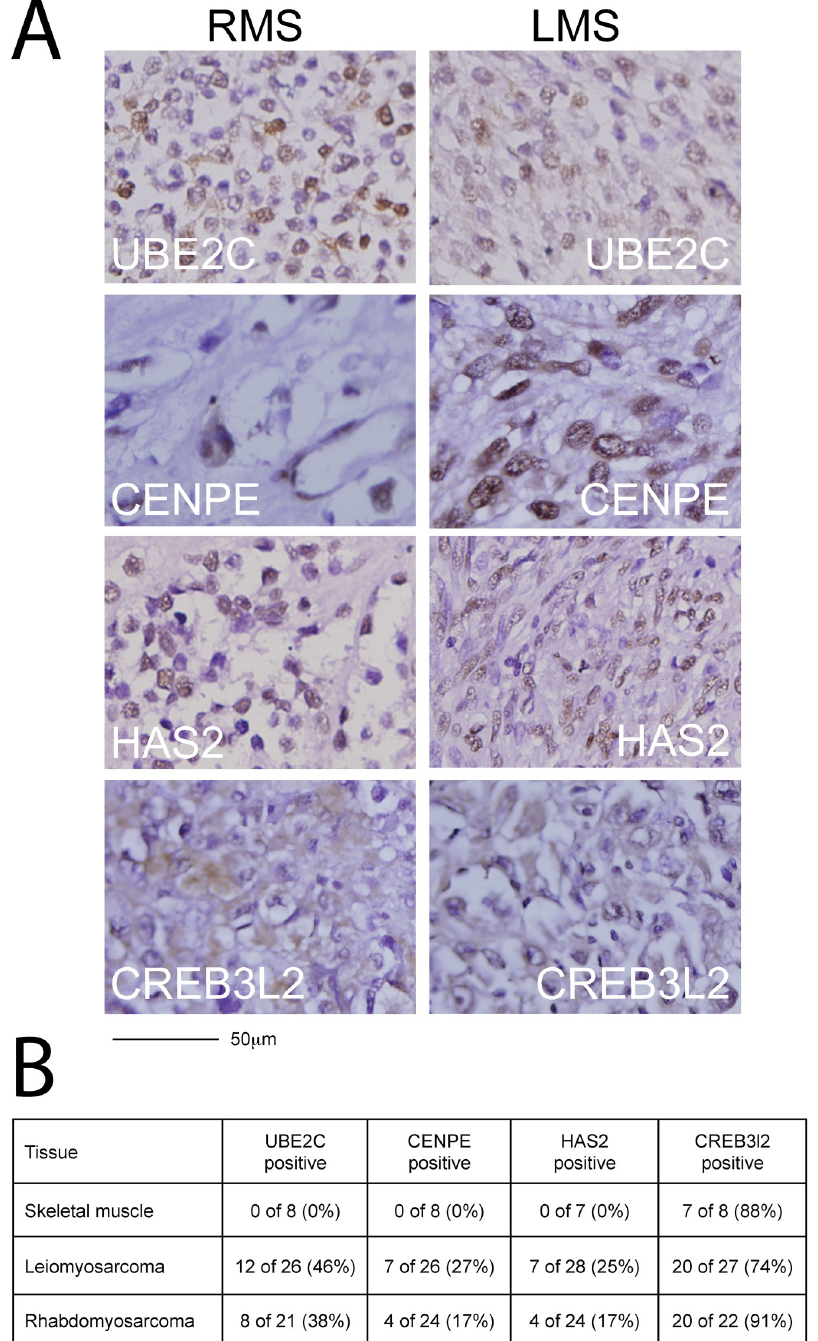
Fig 2. Expression of candidate sarcoma targets in human sarcoma tissue. Immunohistochemical staining of commercially available sarcoma tissue arrays (US Biomax SO2081) was used to confirm candidate expression in human sarcomas. (A) Representative stains in RMS (left column) and high-grade LMS (right column) are shown for UBE2C (top row), CENPE (second row from top), HAS2 (third row from top) and CREB3L2 (bottom row). (B) Candidate proteins were expressed in 17–91% of RMS cores and 27–74% of LMS cores. Please see also S1 and S2 Figs.